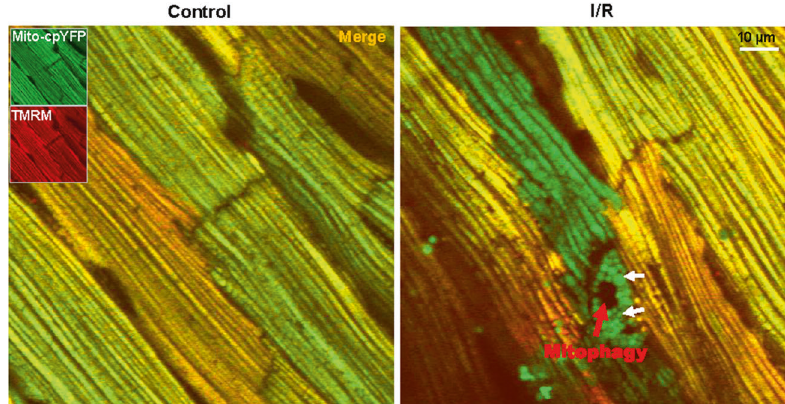
Fig. 4 I/R induces autophagic degradation of mitochondria in cardiac. White arrow: Swollen mitochondria induced by the mPTP opening of the depolarized mitochondria that triggered by reperfusion after glucose deprivation. Red arrow: Depolarized mitochondria have been eliminated by